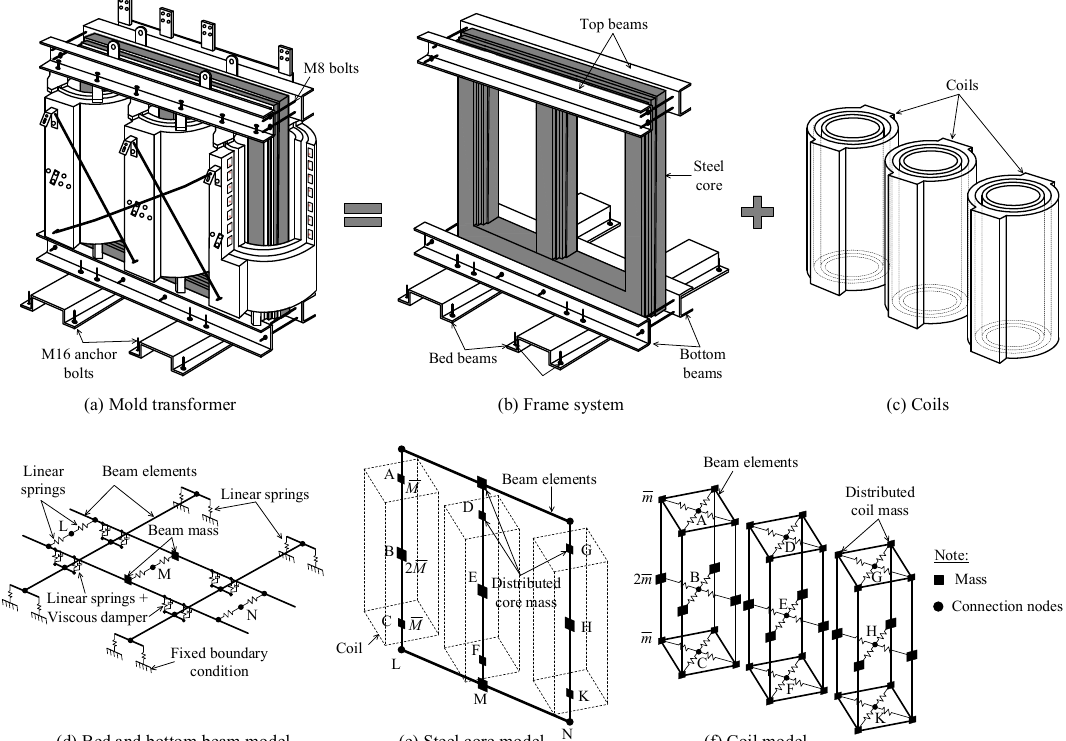
Figure 2. Details of components in analytical model.